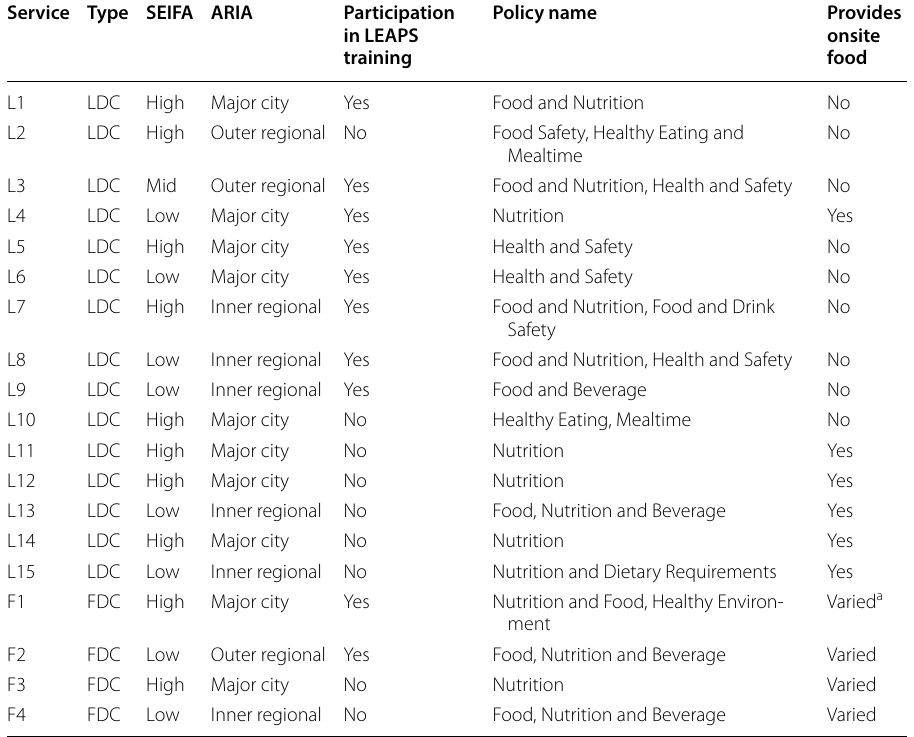
Service Type SEIFA